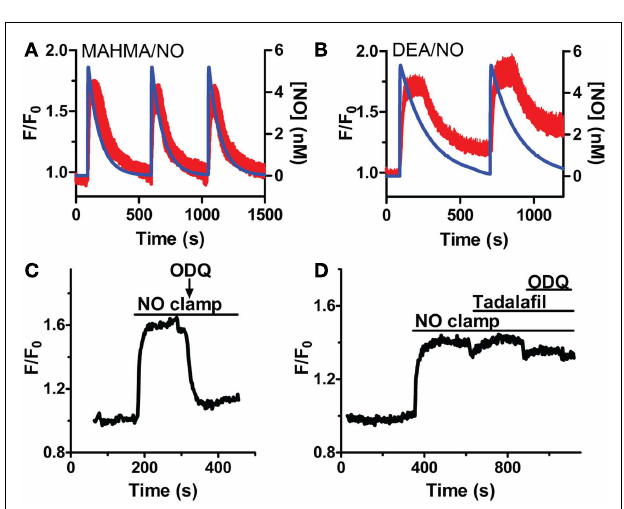
FIGURE 3 | Sensitivity of sGC to steady-state NO inVSM cells. (A) Representative FlincG trace of step-wise concentrations of clamped NO in VSM cells. (B) NO dose-response curve derived from (A ; n = 11). (C) EC 50